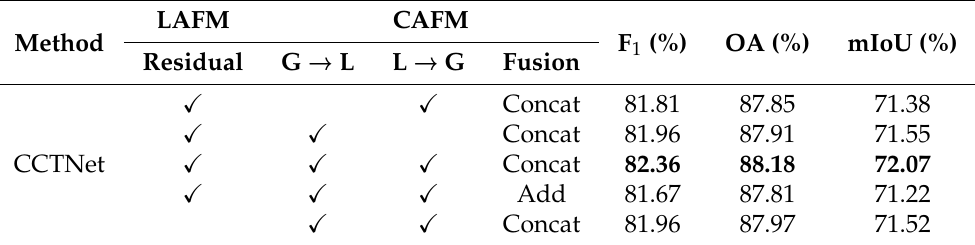
Table 5. Ablation experiments on the structure settings of the LAFM and the